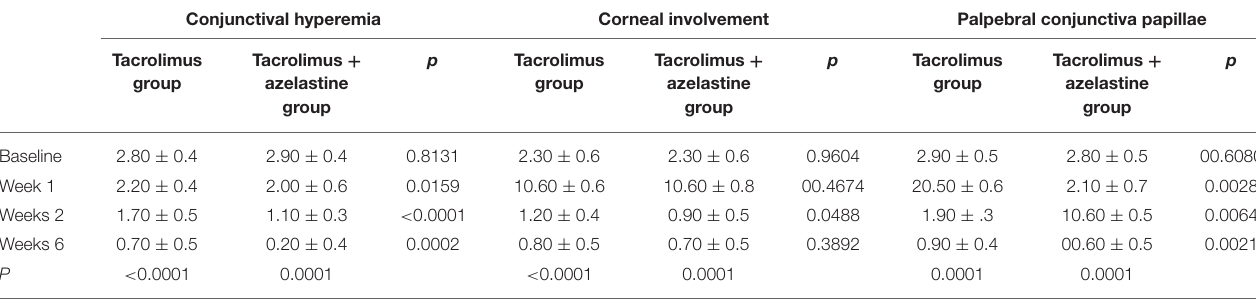
TABLE 2 | Clinical signs before and after therapy. Conjunctival hyperemia Corneal involvement Tacrolimus